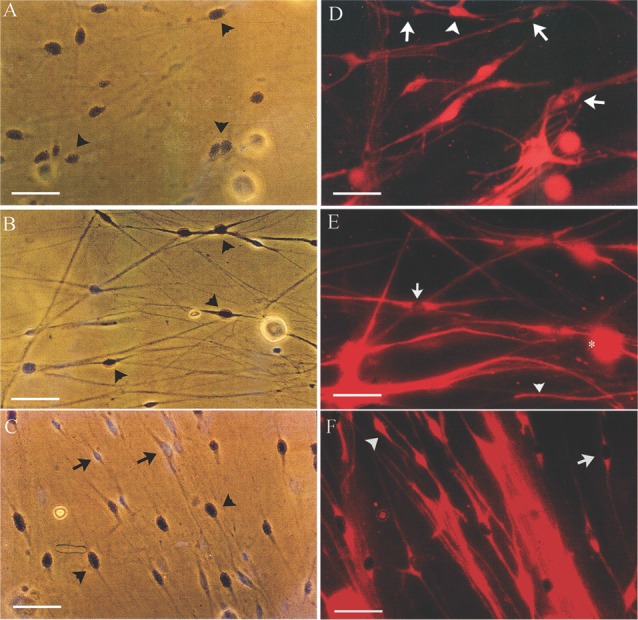
Many SCs in the nerve stump distal to the site of sciatic nerve transection and ligation are in an active proliferative state after acute as well as after chronic denervation, at least for up to 7 weeks. Phase-contrast autoradiographs of isolated acutely (A,D: 7 days) and chronically (B,E: 7 weeks and C,F: 17 months) denervated SCs from right and left hindlimbs, respectively. (A–C) Phase-contrast of the SCs that were exposed to 3H-thymidine for 24 h to identify dividing cells, 5 days after co-culture with DRG neurons. Many of the SCs incorporated 3H-thymidine (arrowhead) demonstrating SCs in an active proliferative state in the acute phase of denervation (A) and up to 7 weeks (B). There are visibly more 3H-Thymidine positive SCs than those that were not dividing (3H-Thymidine—negative cells shown by arrows) after 7 weeks (B) as compared to 7 days (A). (C,D) Immunostaining of SCs with S-100 identifies the dividing SCs (3H-thymidine positive SCs—arrows) and those that do not (3H-thymidine—negative cells shown by arrowheads). The proliferating S-100 positive SCs (arrows) are in close contact with the neurites of the DRG neurons. Scale bars = 30 μm.